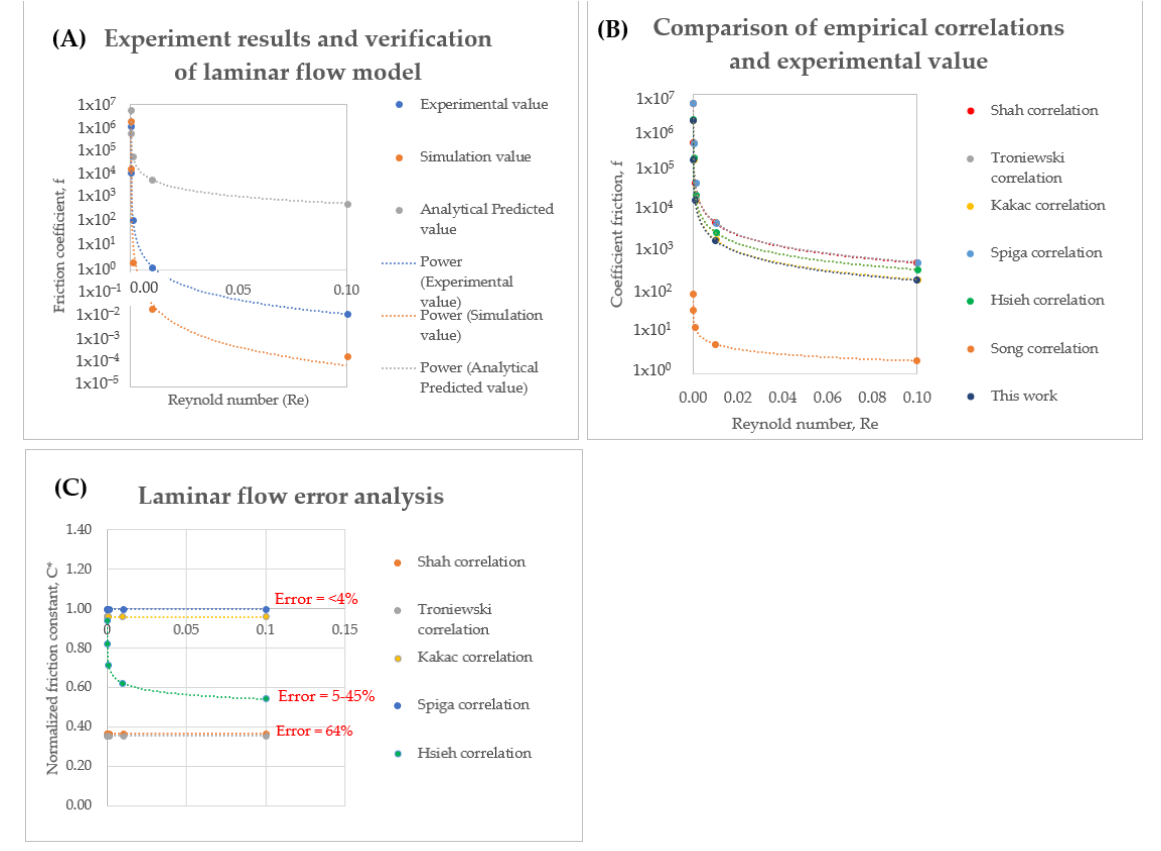
Figure 7. Comparison of friction coefficient ( A ) Experimental, simulation and analytical value in this work ( B ) Comparison of empirical correlation and experimental value ( C ) Laminar flow error analysis. Table 2. Correlations of friction coefficients in rectangular